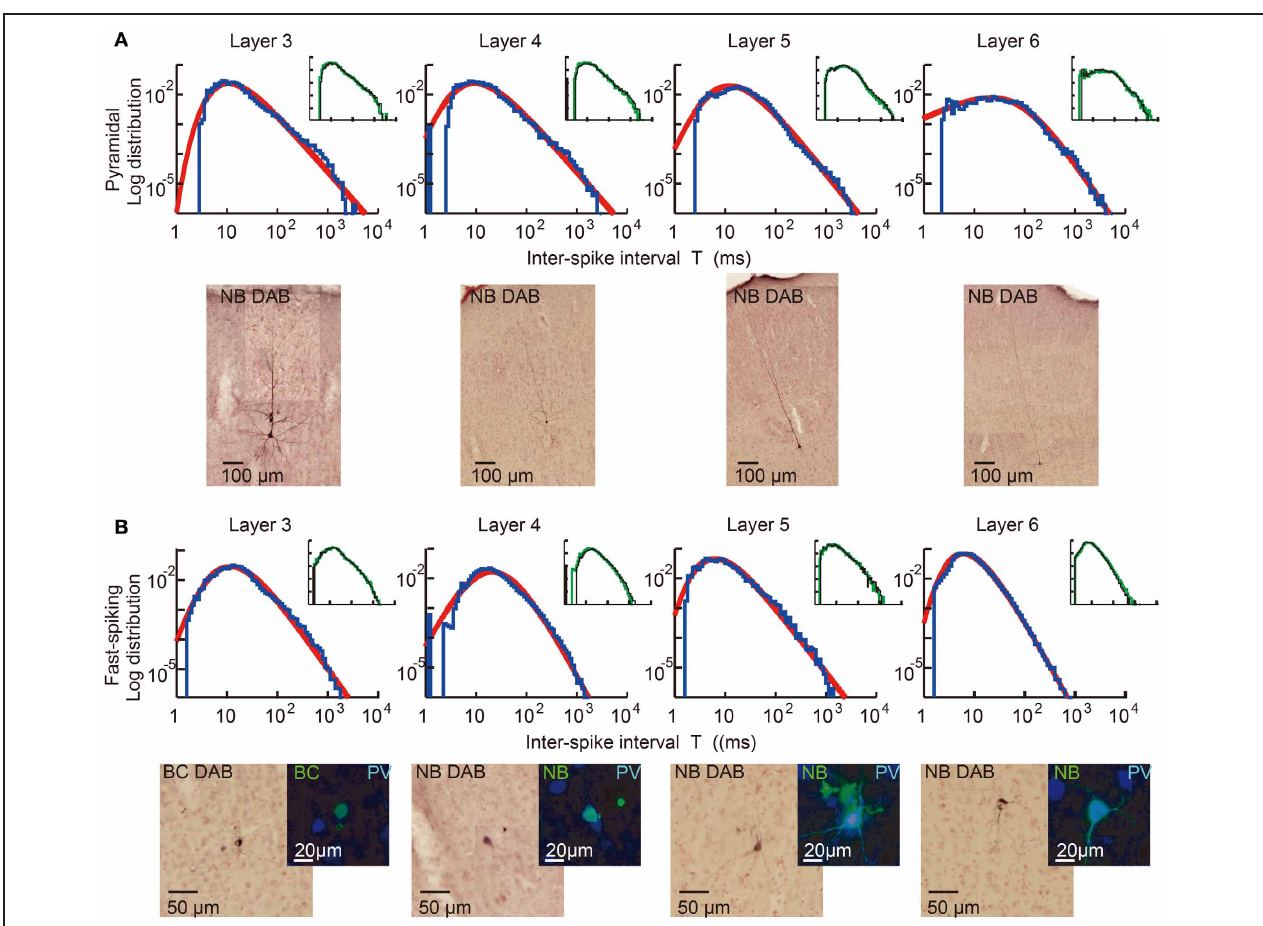
obtained by DAB (3,3 (cid:2) -diaminodbenzidine)-Nickel staining. The four neurons in (B) expressed parvalbumin (PV), a fast-spiking interneuron specific marker (blue: PV, green: biocytin or Neurobiotin). Inset of each panel represents the ISI distributions constructed from the 1st (black) and 2nd (green) halves of the same spike train. They prove the stationarity of the ISI distributions during the recordings. [Modified from Tsubo et al.